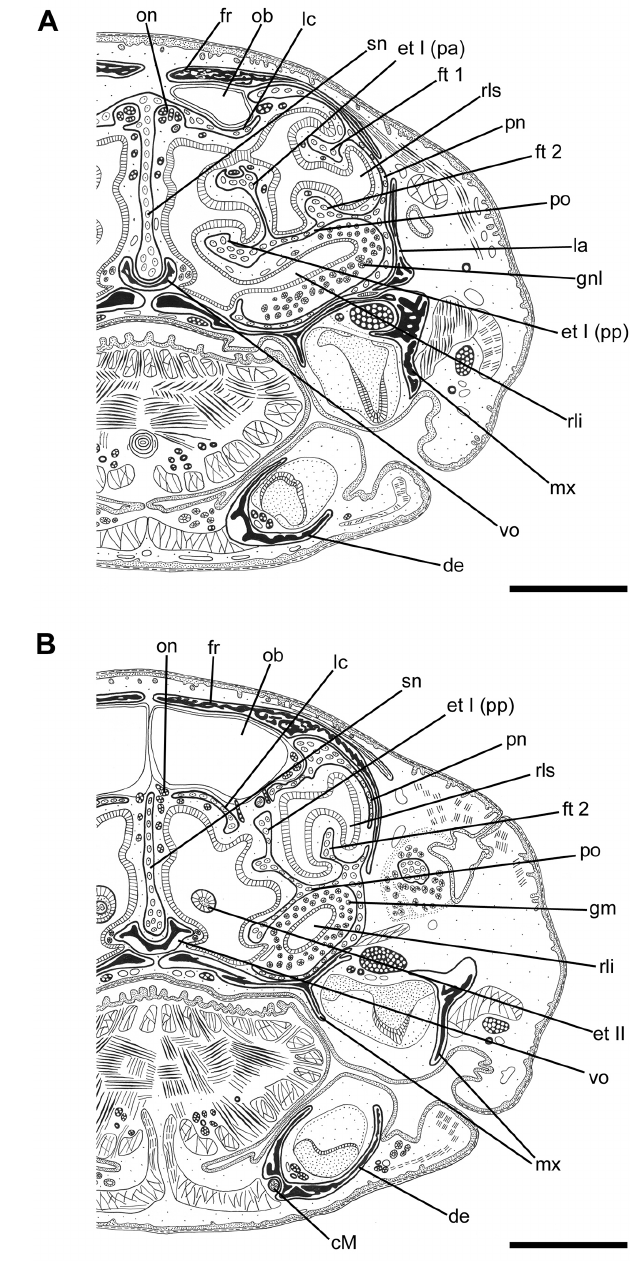
Figure 5. Drawings of histological cross sections through the pars anterior of the fetal nasal cavity from anterior (a) to posterior (b) of Ptilocercus lowii (30mm CRL). Abbreviations: at, atrio- turbinal; cM, cartilago Meckeli; cp, cartilago paraseptalis; de, den- tary; dn, ductus nasopalatinus; dnl, ductus nasolacrimalis; et I, eth- moturbinal I; mt, maxilloturbinal; mx, maxilla; na, nasal; nt, naso- turbinal; pa, pars anterior; pmx, premaxilla; pn, paries nasi; ppm, processus palatinus medialis; sn, septum nasi; st, septoturbinal; tn, tectum nasi; vno, vomeronasal organ. Scale bars equal 2mm.